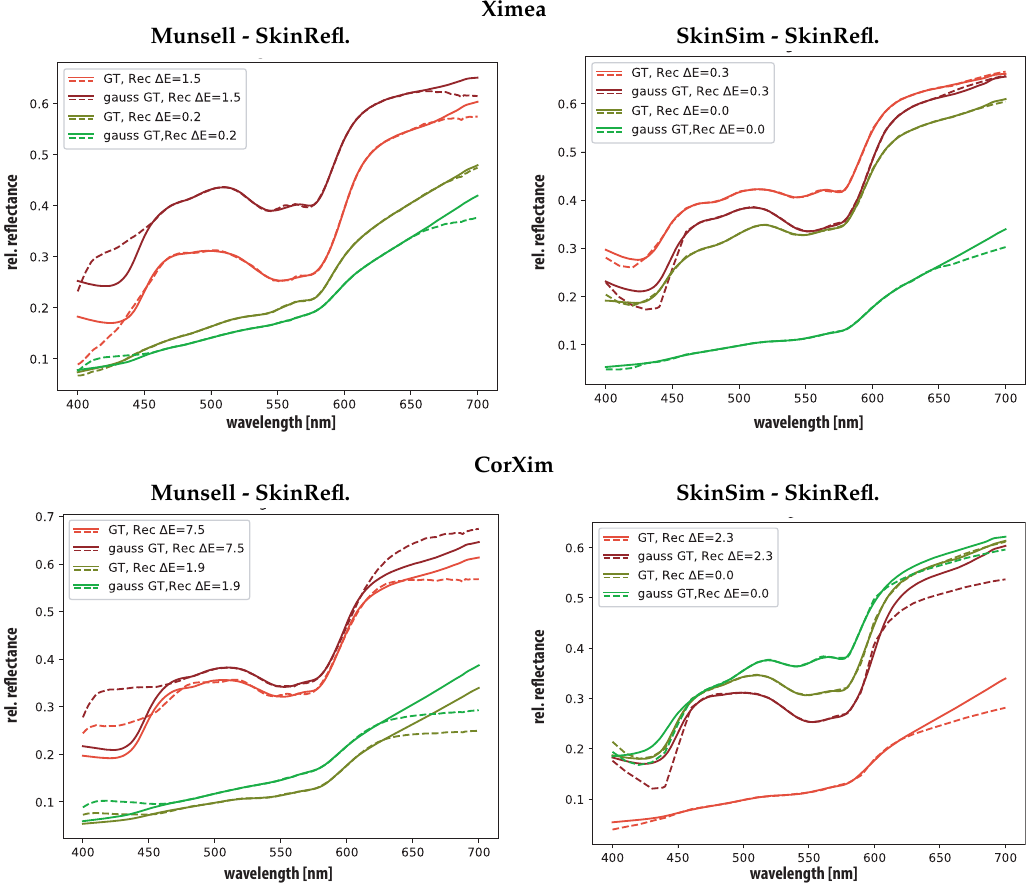
Figure 7. Visualization of worst and best ∆ E 00 results for the uncorrected Ximea (Ximea top) and corrected Ximea (CorXim bottom), Munsell set ( left ) and Skin simulation (SkinSim) set ( right ) as training. Each graph includes GSB sensor results, ground-truth in solid lines and estimation with dashed